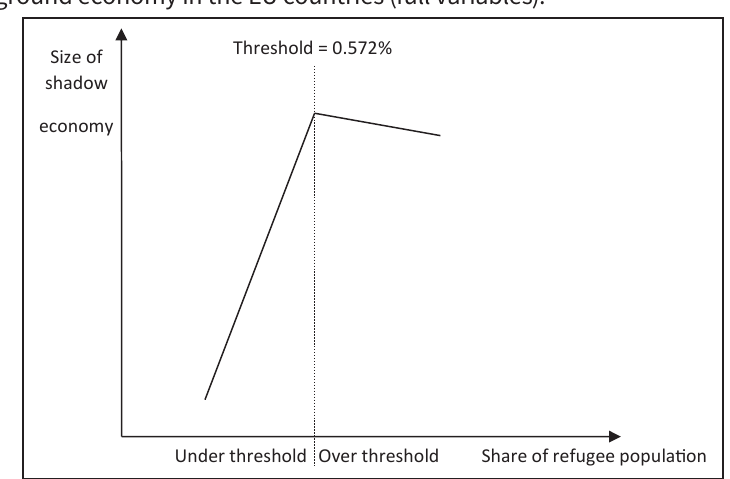
Figure 2 The threshold effect of the share of refugee population on the size of the under- ground economy in the EU countries (full